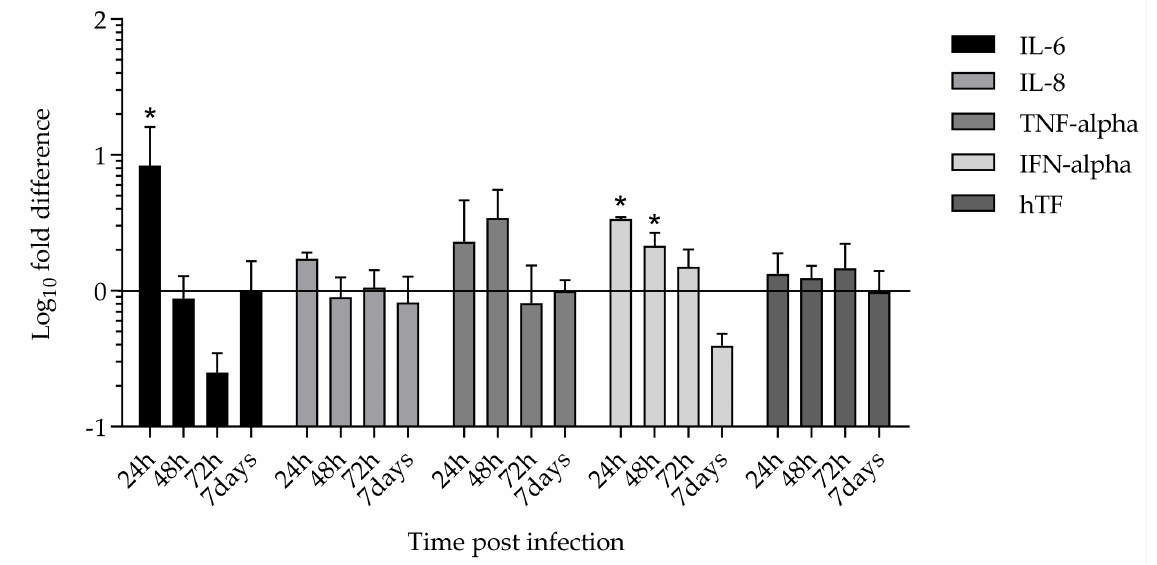
Figure 5. IL-6, IL-8, TNF- α , IFN- α , and hTF transcription in SARS-CoV-2 B.1 infected HMEC-1. log 10 fold-change values above 0 express upregulation of target gene. Cytokines and hTF mRNA levels were assessed by reverse transcription, SYBR Green Real Time PCR, and Fold Difference analysis between uninfected and infected cells at 24, 48, 72 h and 7 days p.i. The cytokines and hTF mRNA expression levels were normalized with GAPDH mRNA level and reported in the figure as log 10 fold difference. Significant difference of IL-6 expression at 24 h and IFN- α at 24 h and 48 h in infected cells compared to uninfected cells was observed; * p <